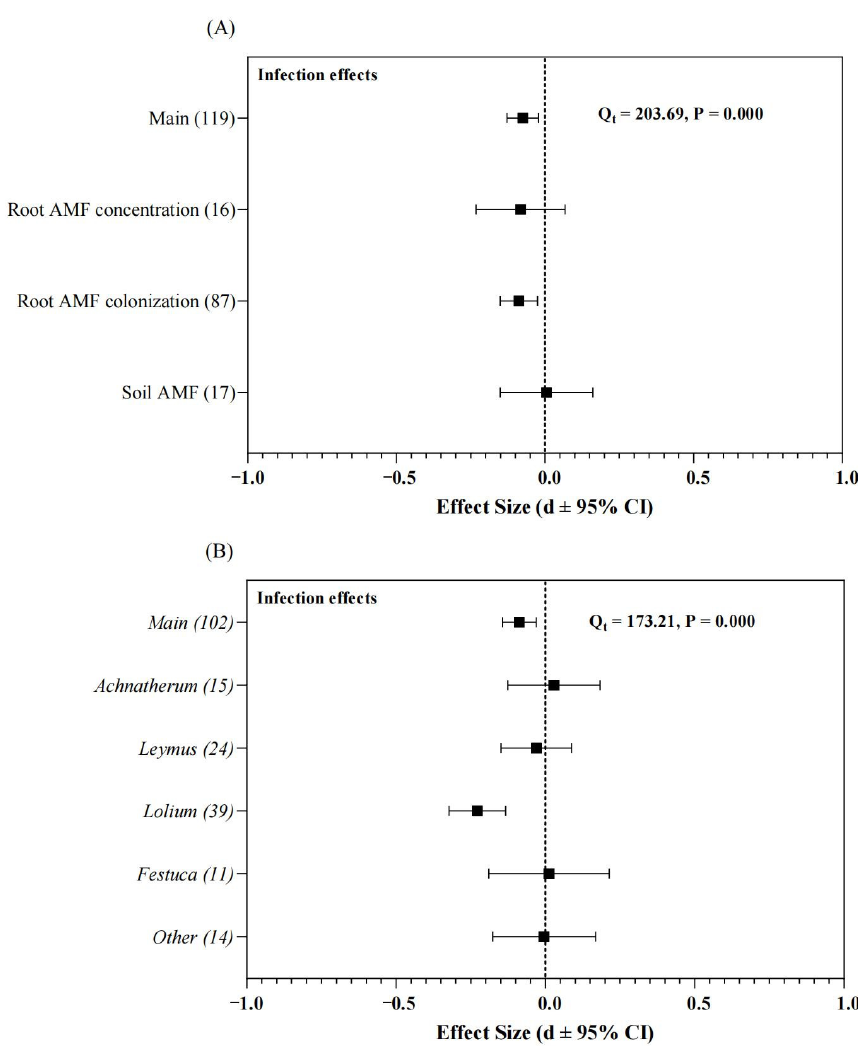
Figure 2. The cumulative effect size of Epichloë endophytes infection on the symbiotic phase of the grass and arbuscular mycorrhizal fungi (AMF) development among ( A ) soil and root AMF effects or ( B ) root AMF colonization of different plant genera. The squares indicate the mean values and the bars denote the 95% confidence interval (CI).